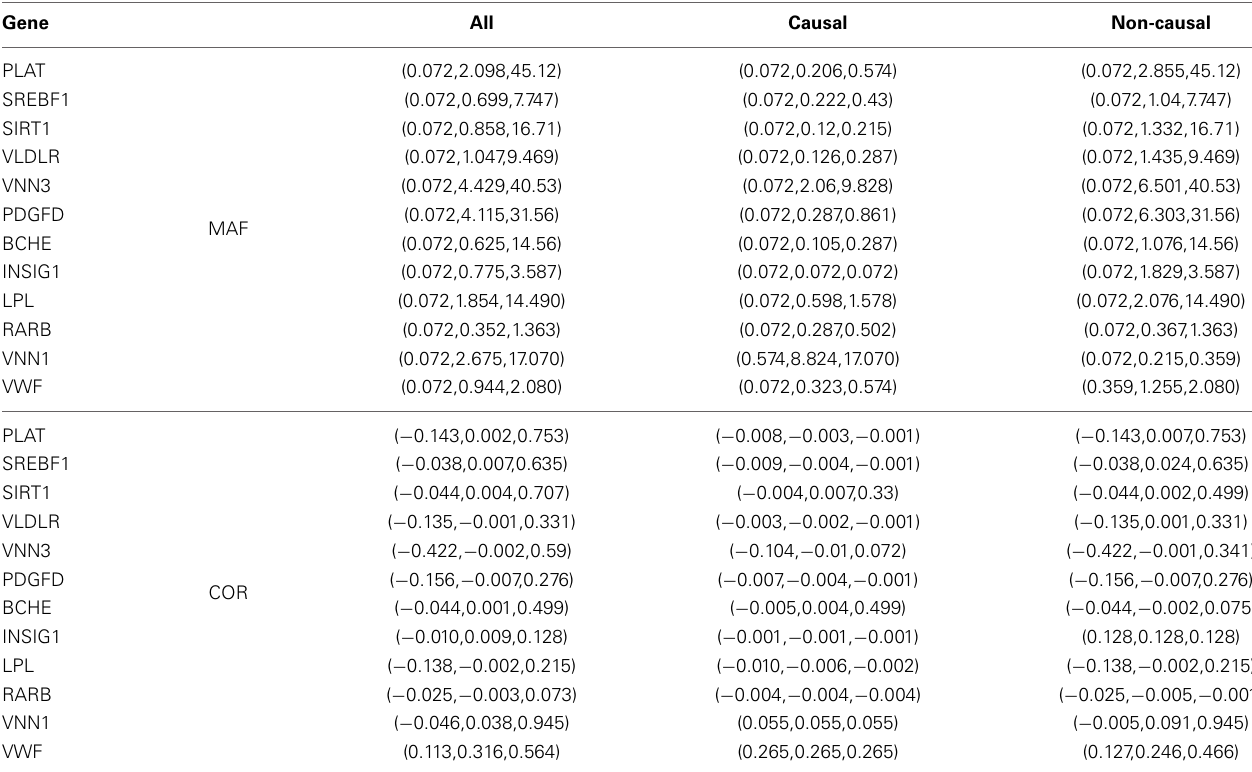
Table 5 | MAFs (%) and pair-wise correlations (COR) in the values of (min, mean, max) for the 12 genes influencing the quantitative trait Q2 in the GAW17